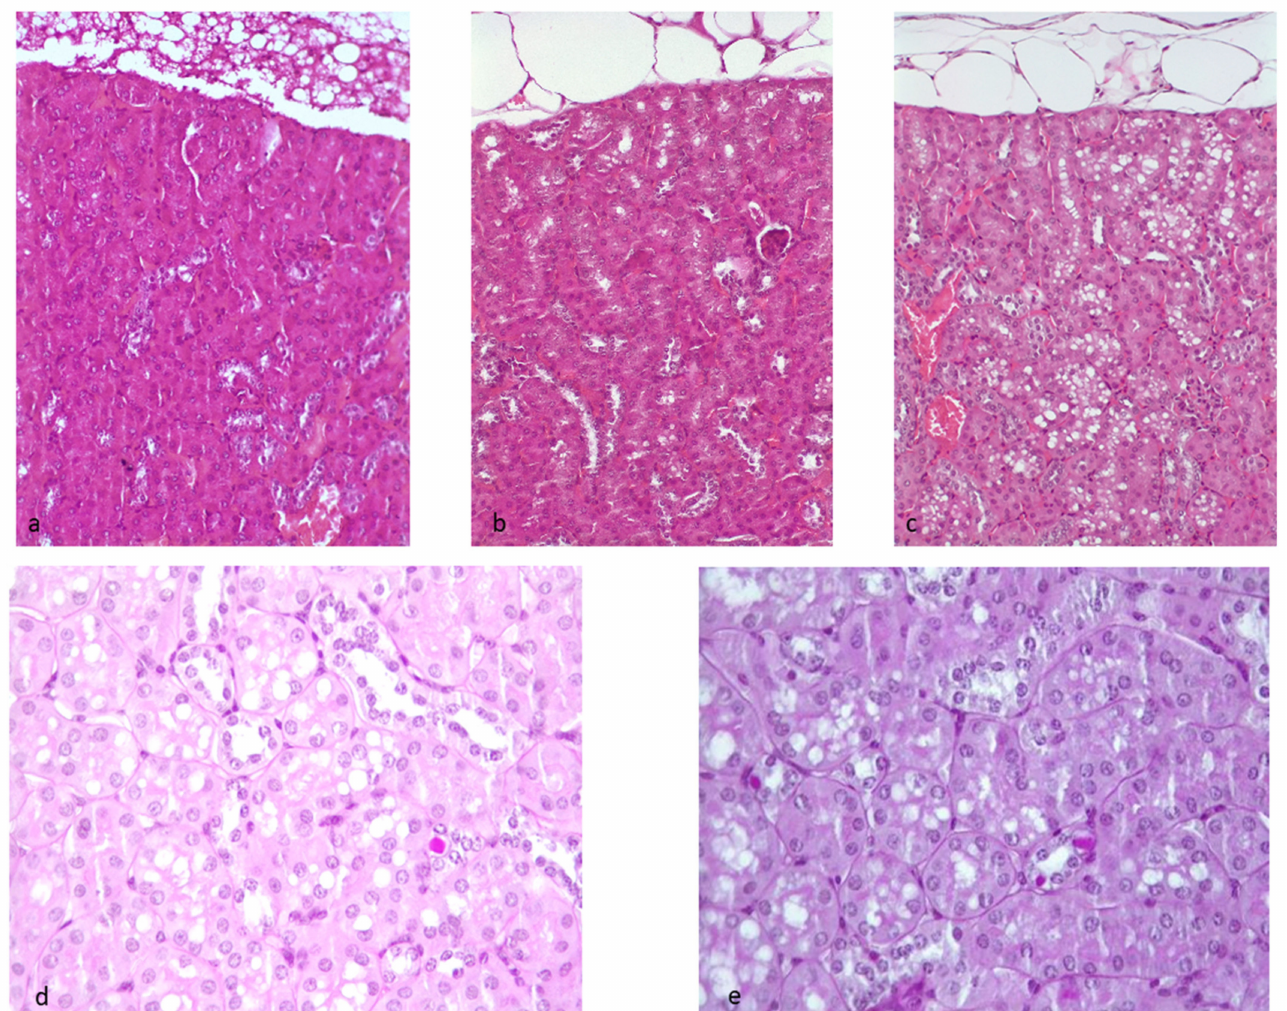
Figure 7. Histological examination. Hematoxylin- and eosin-stained kidney sections from normal chow (CTR) or high-fat (HF) fed mice at the end of 20 weeks. ( a ) CTR, normal cortex; ( b ) HF mouse: tubular vacuolation score 1, ( c ) HF mouse: tubular vacuolation score 2. PAS-stained kidney sections from HF-fed mice at the end of 20 weeks. ( d ) HF-mouse score 1: one glycogenated nucleus is visible; ( e ) HF mouse score 2: three glycogenated nuclei are